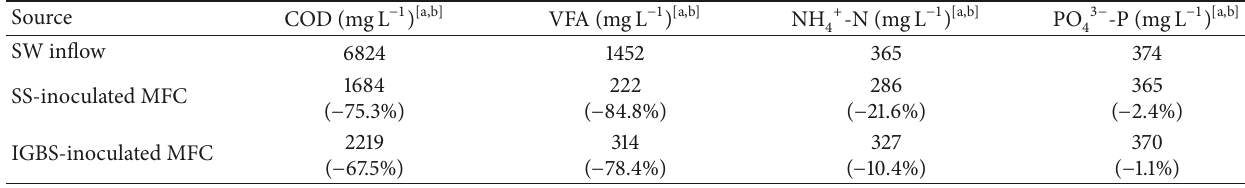
Table 1: Treatment-related characteristics of swine wastewater-fed microbial fuel cells. Source